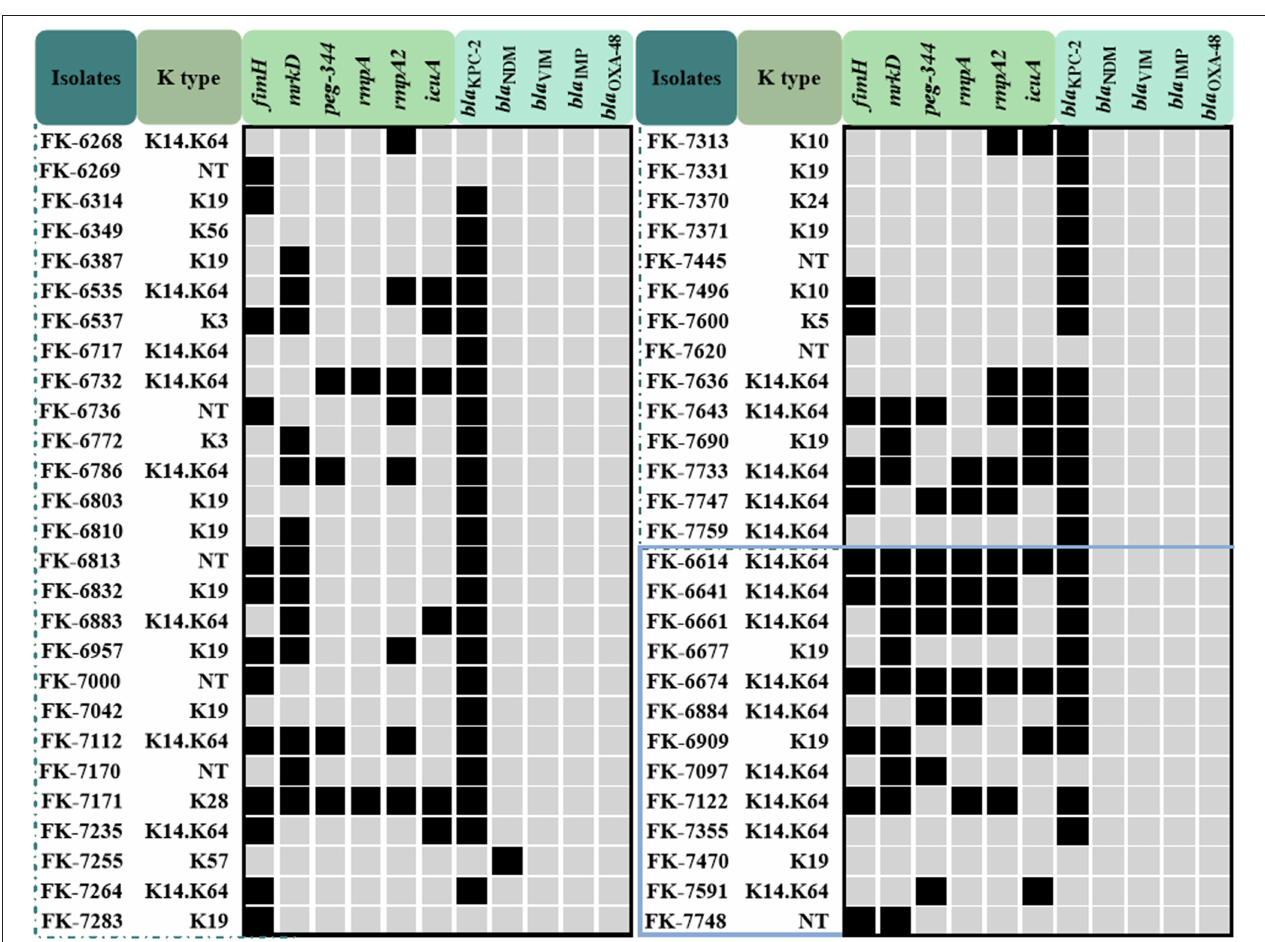
FIGURE 1 | The capsular serotype, virulence genes and carbapenemase genes map of the colonization group and the infection group CRKP strains. The strains in the blue box represent the infection group strains, the others are the colonization group strains.